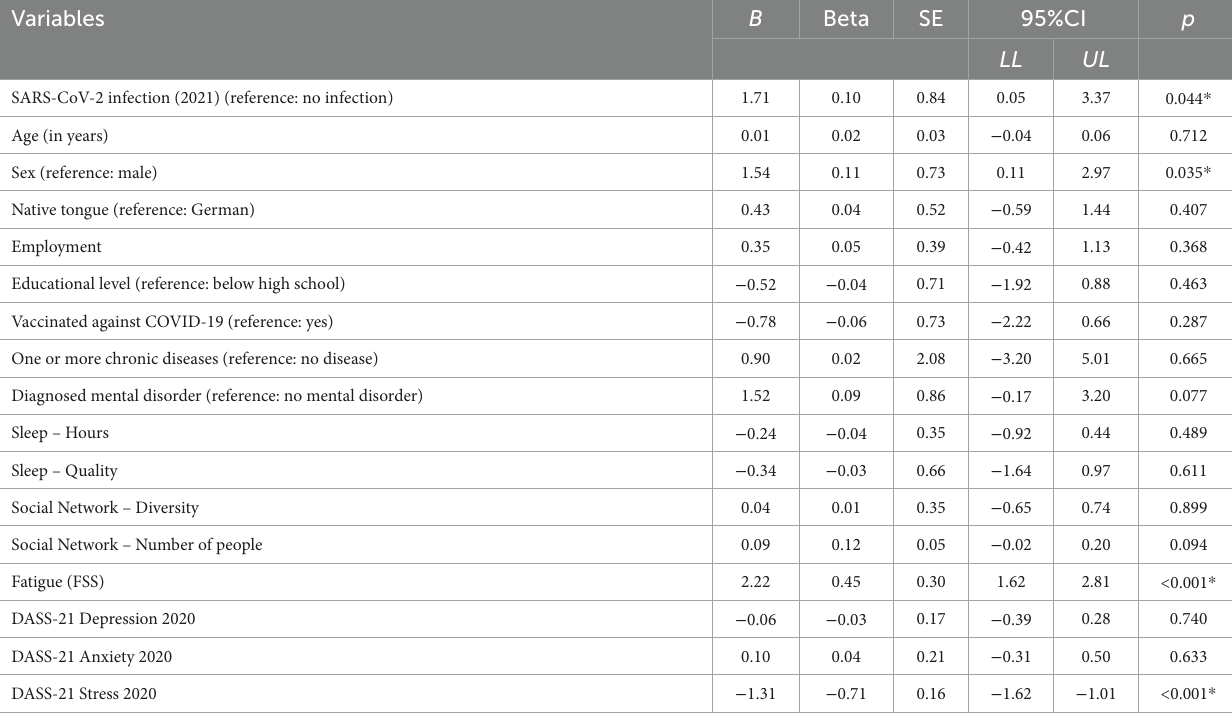
TABLE 6 Multiple linear regression analyses showing the association between confirmed SARS-CoV-2-infection and changes in stress (DASS-21 stress subscale) between 2020 and 2021 ( n = 305). Variables B Beta SE 95%CI